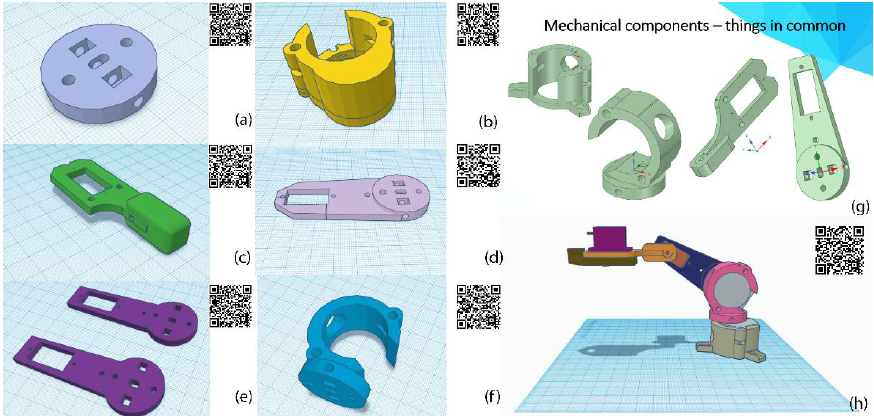
Figure 3. Students’ work ( left ) during the exercises with the parts of the robotic arm ( right ). The QR codes contain direct links to the pieces designed in the Tinkercad platform (for access, an ac- count is required). ( a ) A piece of the arm and the stepper motor base; ( b ) stepper motor holder; ( c ) gripper holder; ( d ) the arm; ( e ) the arm; ( f ) stepper motor holder; ( g ) mechanical components— things in common (a slide from the lesson presentation); ( h ) robotic arm representative assembly.